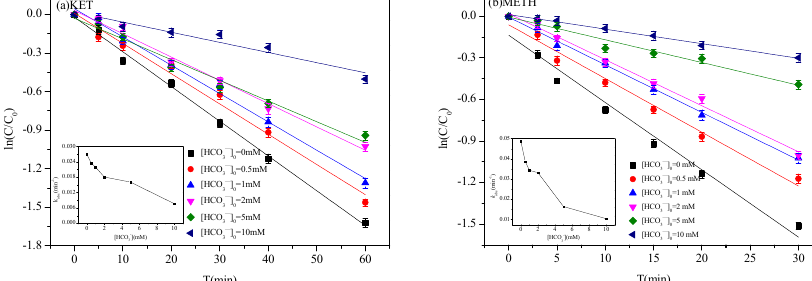
Figure 7. E ff ect of HCO 3 − on KET ( a ) and METH ( b ) degradation in UV / H 2 O 2 system. Conditions: (KET) 0 = (METH) 0 = 100 µ g / L, (H 2 O 2 ) 0 = 500 µ M, pH 0 = 7.0, T = 25 ± 1 ◦ C. Figure 7. Effect of HCO 3− on KET ( a ) and METH ( b ) degradation in UV/H 2 O 2 system. Conditions: (KET) 0 = (METH) 0 = 100 μg/L, (H 2 O 2 ) 0 = 500 μM, pH 0 = 7.0, T = 25 ± 1 °C.